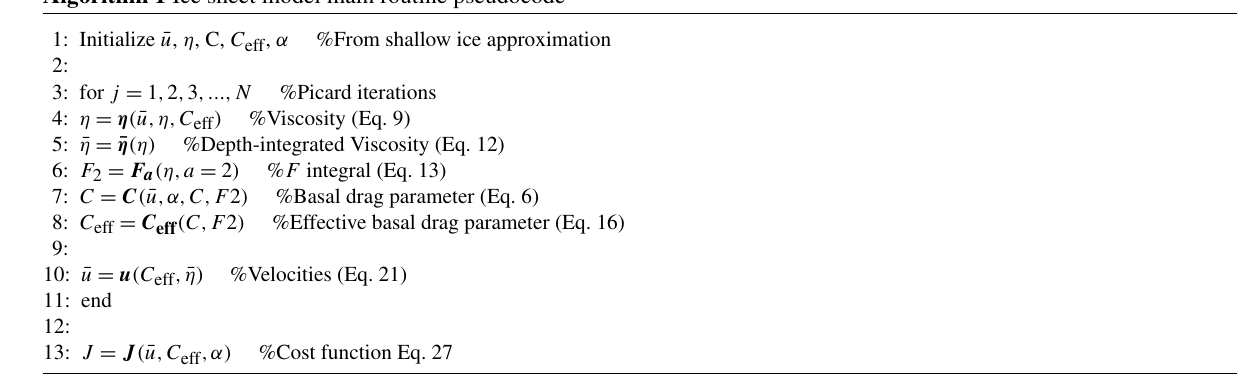
Algorithm 1 Ice sheet model main routine pseudocode